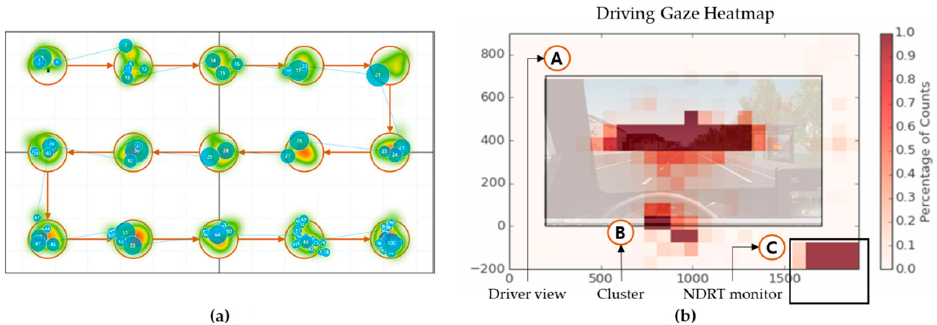
Figure 6. Gaze tracking: (a) calibration targets; (b) gaze tracking results (manual driving